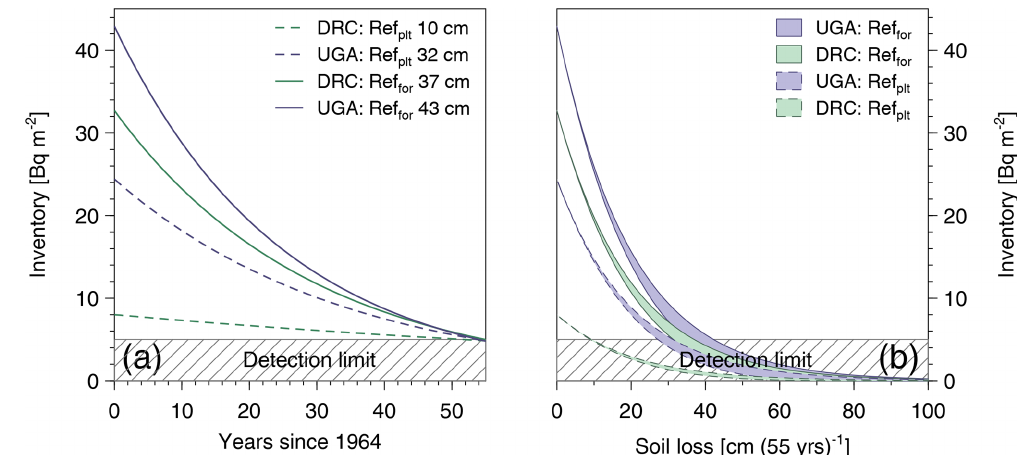
Figure 4. DR Congo (DRC) and Uganda (UGA) cropland soil erosion results of the mass balance model. A scenario assessment was carried out to understand 239 + 240 Pu inventory reduction until the detection limit is reached after the simulation period: (a) soil erosion magnitude and corresponding (b) soil erosion frequency according to the mean forest (Ref for ) and mean cropland plateau (Ref plt ) assumptions. Panel (a) represents the minimum quantity of soil erosion to pass the detection limit with different reference 239 + 240 Pu inventories. All displayed curves show the corresponding scenario runs of minimum soil erosion to cause a 239 + 240 Pu inventory reduction that falls below the detection limit. (b) Comparison between a continuous 55-year soil erosion rate vs. 5 erosive years that cause the same quantity of soil erosion. Soil erosion from 1 to 100cm (55yr) − 1 is simulated. The coloured area describes the difference between the two scenarios, where the lower line is the 5-year